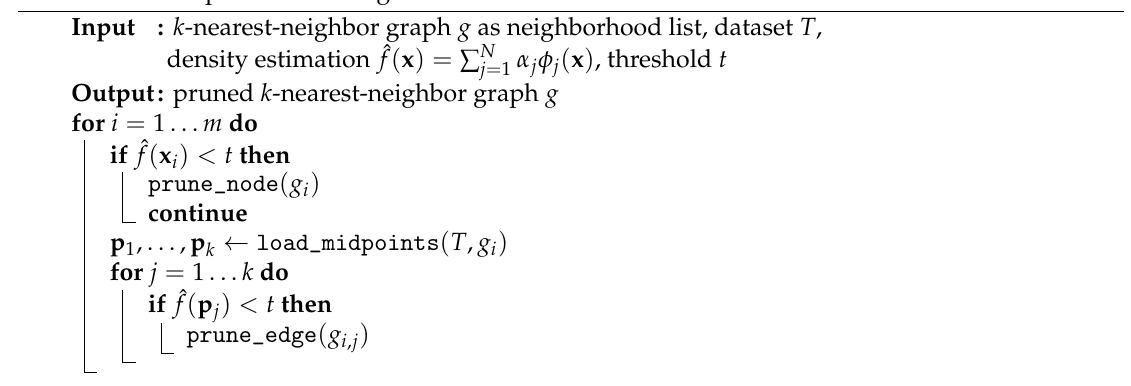
Algorithm 4: A streaming algorithm for pruning low-density nodes and edges of the k -nearest-neighbor graph. The density function is evaluated at the location of the nodes and at the midpoints of the